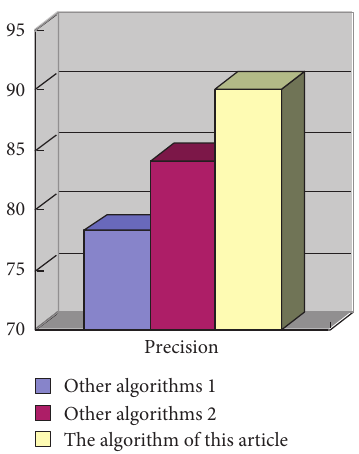
Figure 5: Performance comparison of different kernel functions.